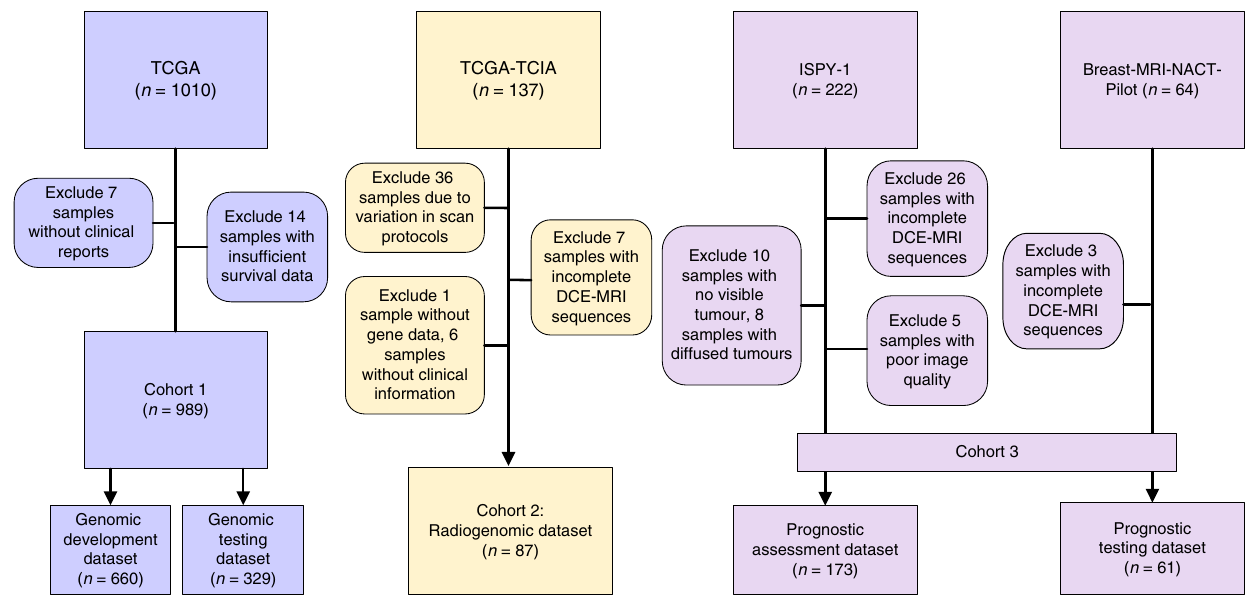
Fig. 2 Data organization fl owchart of three data cohorts. A total of 1310 samples of breast cancer patients were included in fi ve datasets of three data cohorts according to the selection